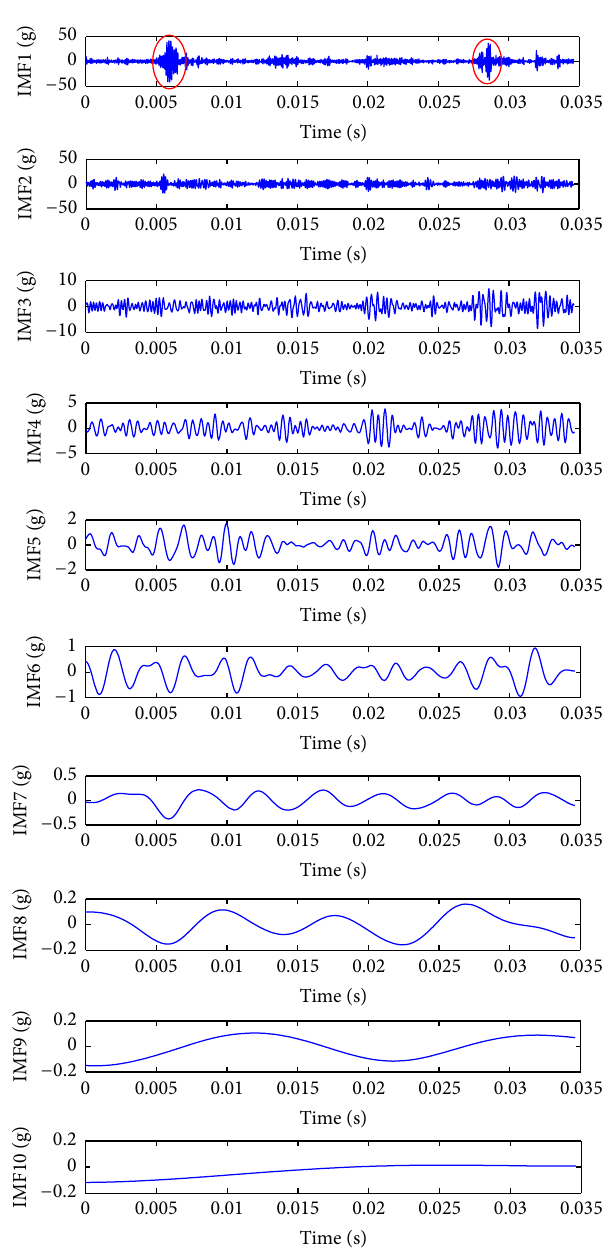
Figure 10: Decomposition results of CEEMD for cylinder block vibration